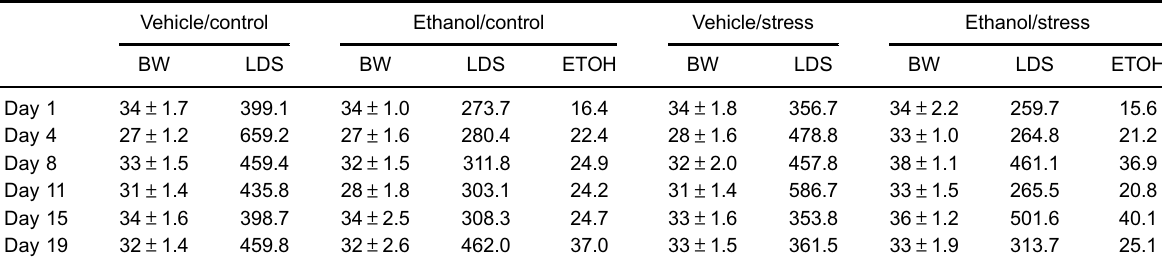
Table 1. Body weight, amount of liquid diet solution and ethanol solution consumed in the